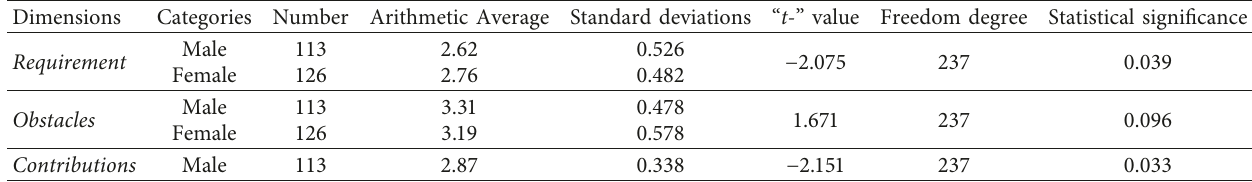
Table 8: Arithmetic averages, standard deviations, and t -test for gender’s impact on distance education requirements, difficulties, and proposed remedies in the face of university educational crises.